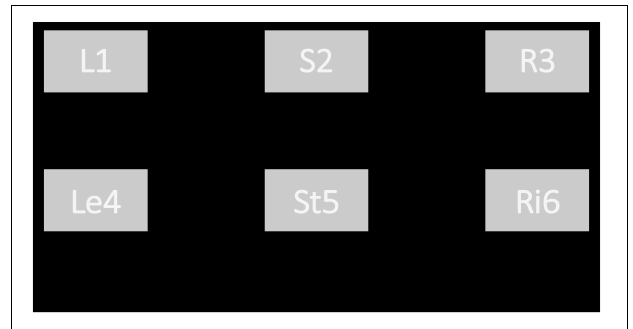
FIGURE 1 | The spatial distributions of augmented reality